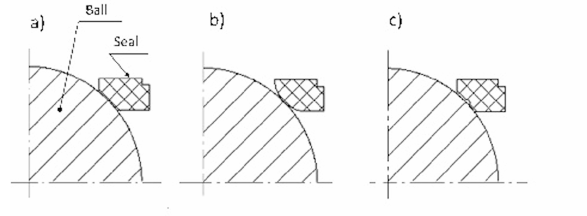
Figure 2: Types of seal construction were considered in tests with various geometry of contact area; a) concave shape – variant 1, b) convex shape – variant 2, c) concave shape with peripheral